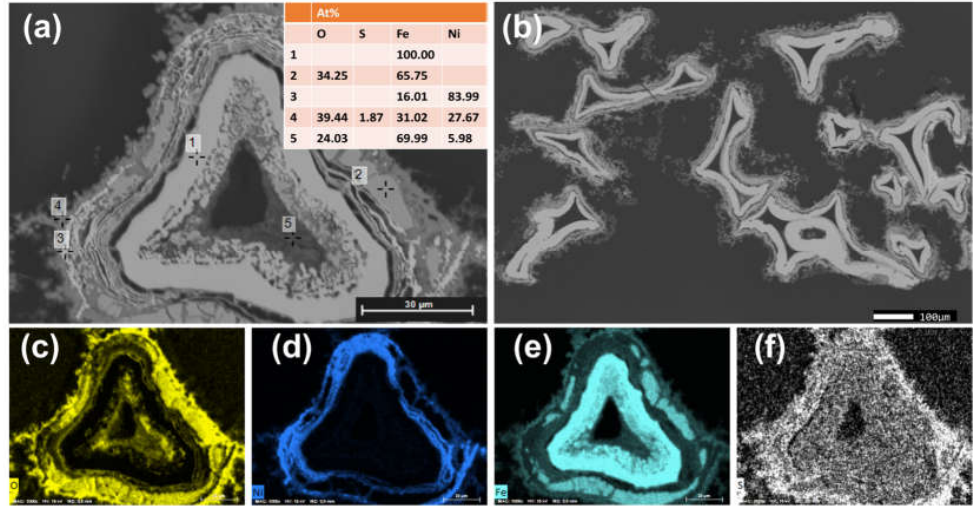
Figure 5. Cross-sectional SEM images of Ni-Fe electrode in the as-prepared state ( a , b ) and elemental mapping images for ( c ) oxygen, ( d ) nickel, ( e ) iron, and ( f ) sulfur.